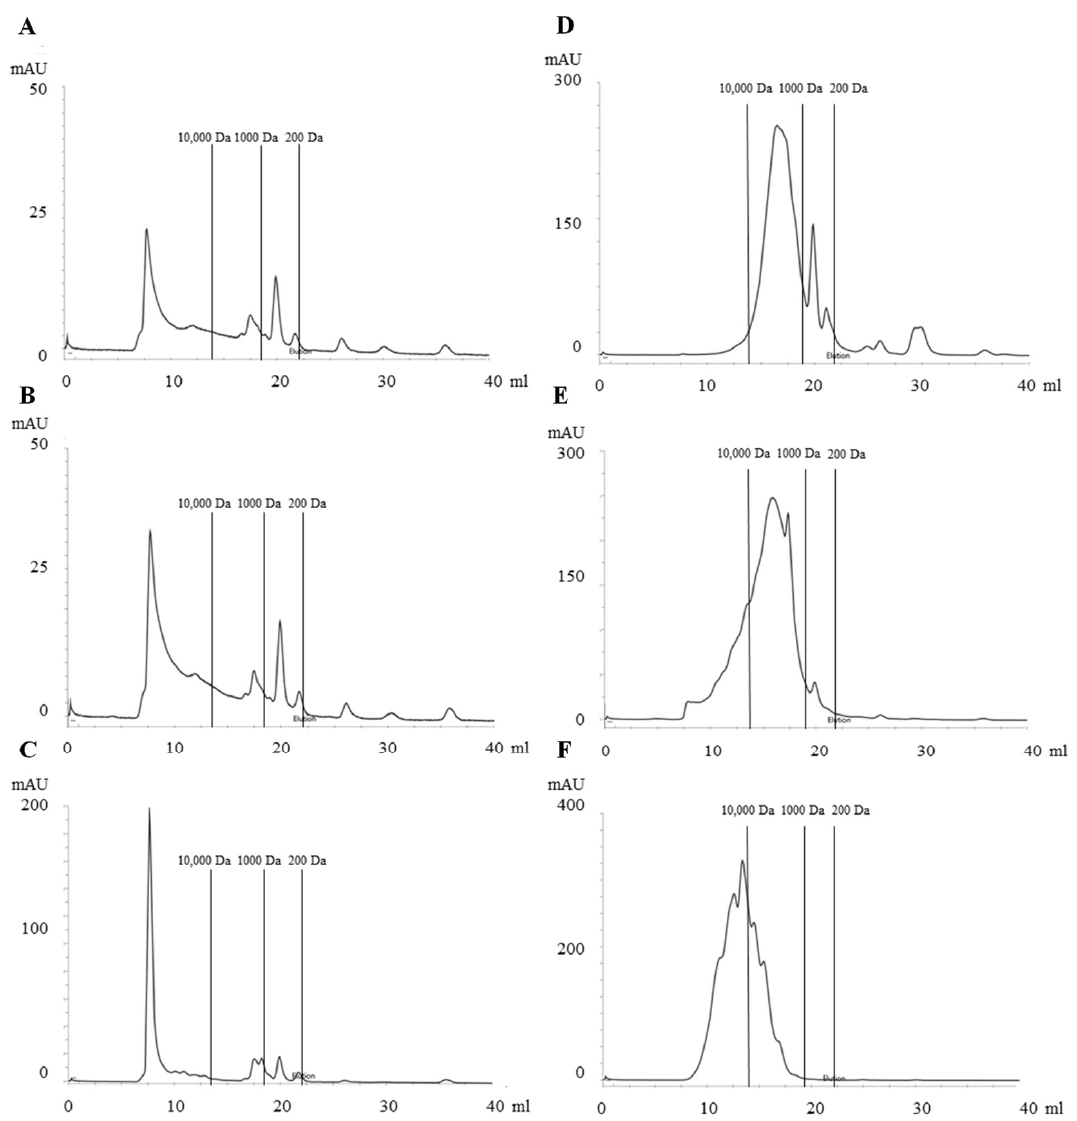
Figure 2. Size exclusion chromatograms (SEC) of commercial fish protein concentrates, hydrolysates, and hydrolyzed collagen. ( A ) CONC1, ( B ) CONC2, ( C ) CONC3, ( D ) HYDR1, ( E ) HYDR2, and ( F ) COLL1. Fish protein concentrates = CONC1–3, fish protein hydrolysates = HYDR1–2, hydrolyzed fish collagen =